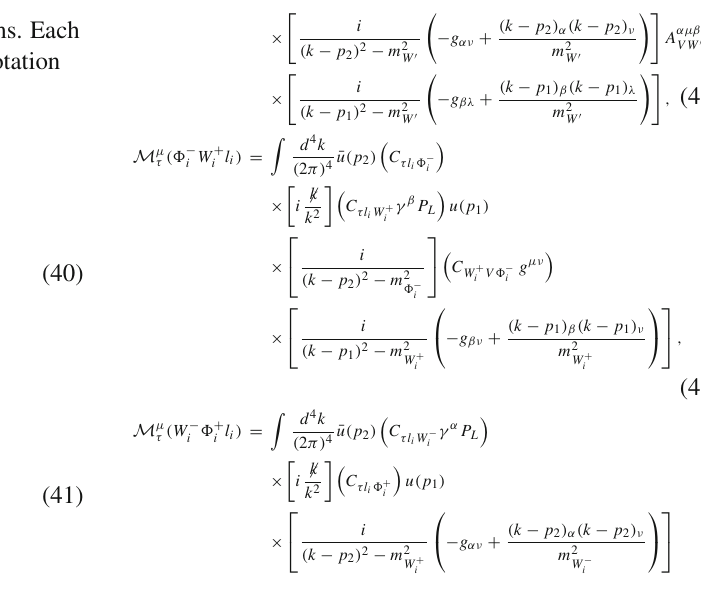
= W ± , W (cid:2)± , and (cid:7) ± = φ ± ,η i i